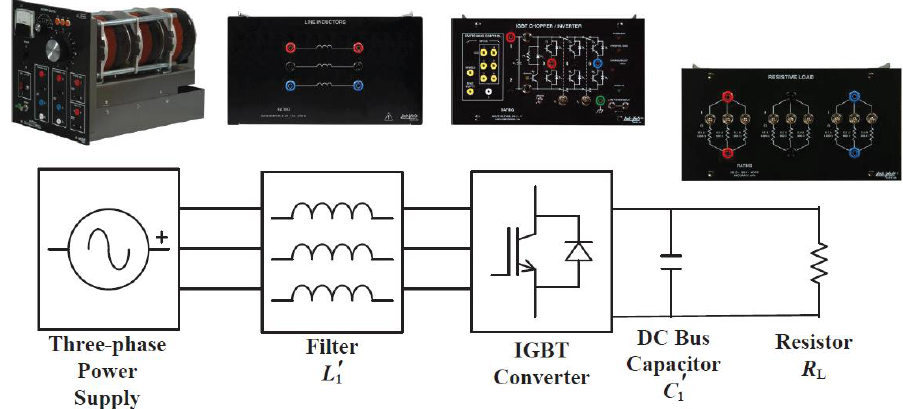
Figure 6. The configuration of the rectifier controller experiment.